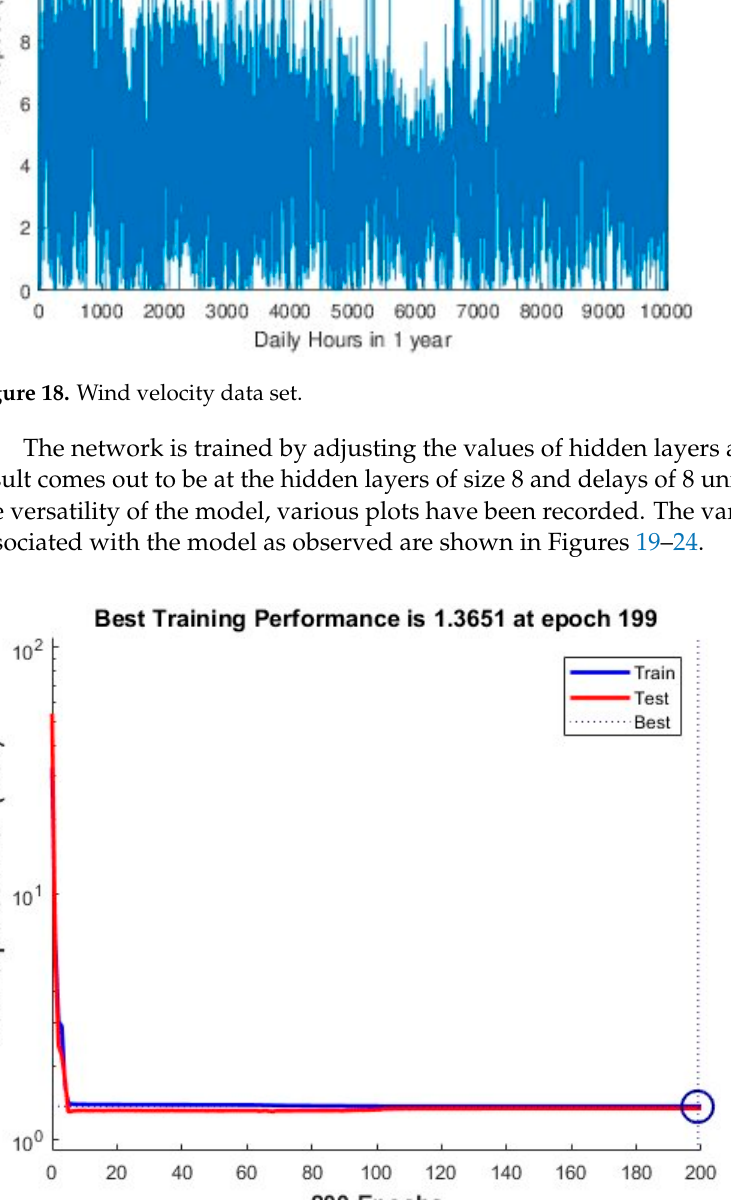
Figure 20. Regression plots of neural network (wind velocity forecasting case).